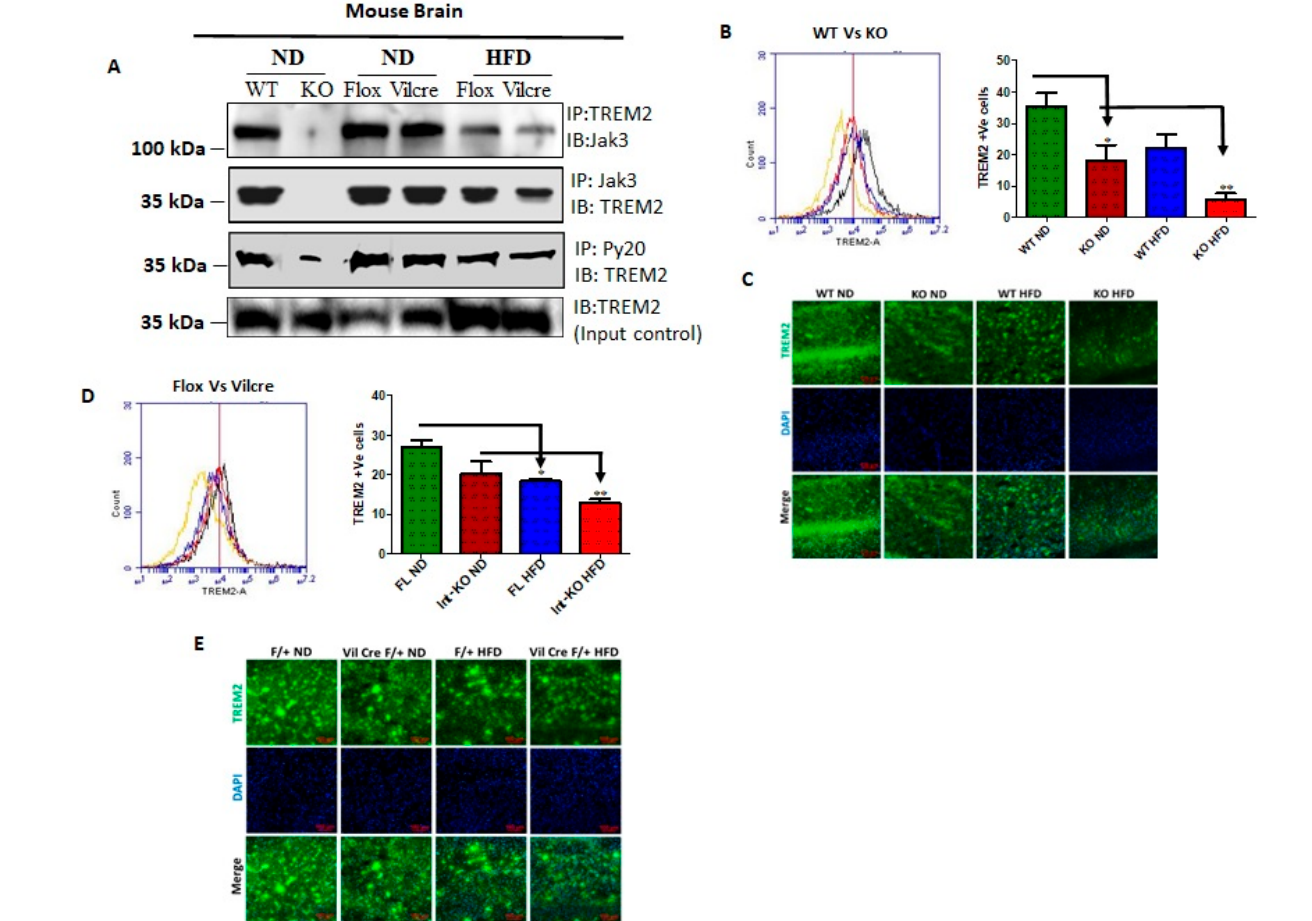
Figure 4. The triggering receptors on microglial cells 2 (TREM2) interact with Jak3 in the brain, and the intestinal deficiency of Jak3 leads to reduced interactions and expression of TREM-2 in the brain with Jak3 during HFD-induced obesity: ( A ) Jak3 interactions with TREM-2 were determined using brain tissue lysates from ND- and HFD-fed mice. Lysates from WT (littermate control), Jak3-KO, IEC-Jak3-KO and flox-Jak3 (littermate control) were subjected to IP followed by IB using the indicated antibodies. Blots shown represent n = 3 experiments. ( B ) The impact of global and intestinal epithelial tissue-specific deficiencies of Jak3 on the brain expression of β -Amyloid receptor TREM2 on microglial cells was determined in ND- and HFD-fed mouse brain. Representative flow cytometric histogram graphs of individual mouse brain cells showing the microglial levels of expression of TREM-2 receptor in the four groups ( n = 5/group; WT-ND (littermate control), Jak3-KO-ND, WT-HFD (littermate control), Jak3-KO-HFD) are shown in the left panel, and the corresponding histogram bar graphs indicating mean ± SD values are shown for the comparative average cell counts for the indicated groups of mice. * Indicate statistically significant difference from the corresponding controls (KO-ND p = 0.05, KO-HFD p = 0.03). ** Comparison between Int-KO ND and Int-KO HFD group. ( C ) Brain tissue sections from WT-control littermate and Jak3-KO mice fed with either ND or HFD were immunostained using TREM-2 primary antibodies followed by FITC secondary antibodies, and mounting media containing PI were used to visualize the nucleus. Representative images ( n = 10) are shown. ( D ) Data from similar experiments as in “B” but for the four different groups of mice ( n = 5/group; flox-Jak3-ND (littermate control), IEC-Jak3-KO-ND, flox-Jak3-HFD (littermate control), IEC-Jak3-KO-HFD) are shown. * Indicate statistically significant difference from the corresponding controls (IEC-Jak3-KO-ND p = 0.05, KO-HFD p = 0.05). ( E ) Brain tissue sections from flox-Jak3-control littermate and IEC-Jak3-KO mice fed with either ND or HFD were immunostained using TREM-2 primary antibodies followed by FITC secondary antibodies, and mounting media containing PI were used to visualize the nucleus. Representative images ( n = 10) are